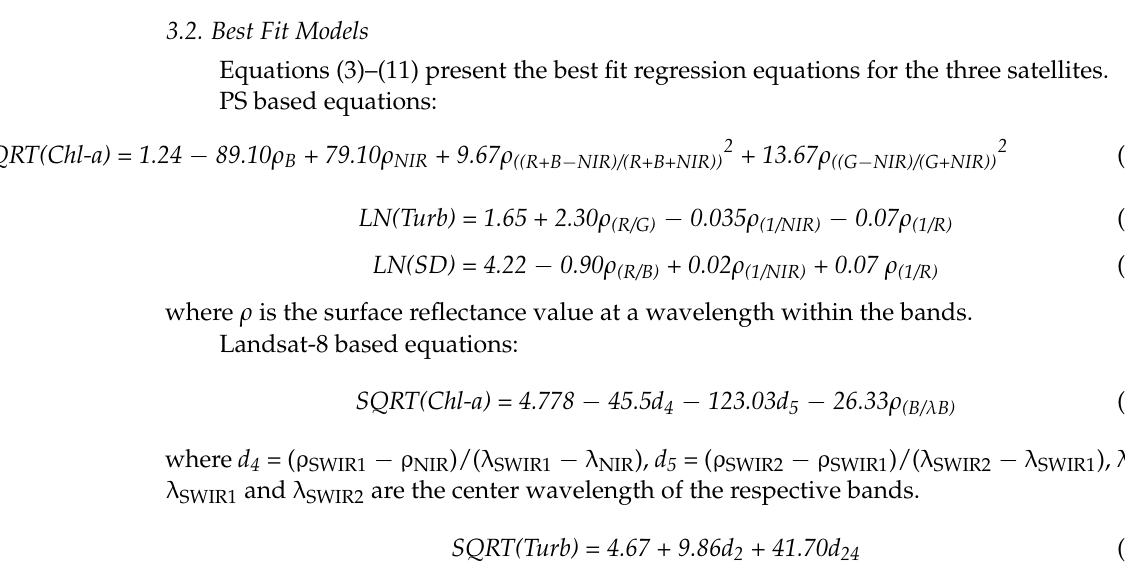
Figure 3. Histograms of the Chl-a ( µ g/L), Turb (NTU), and SD (cm) data from the study reservoirs that correspond to their respective PS, Landsat-8, and Sentinel-2 images.